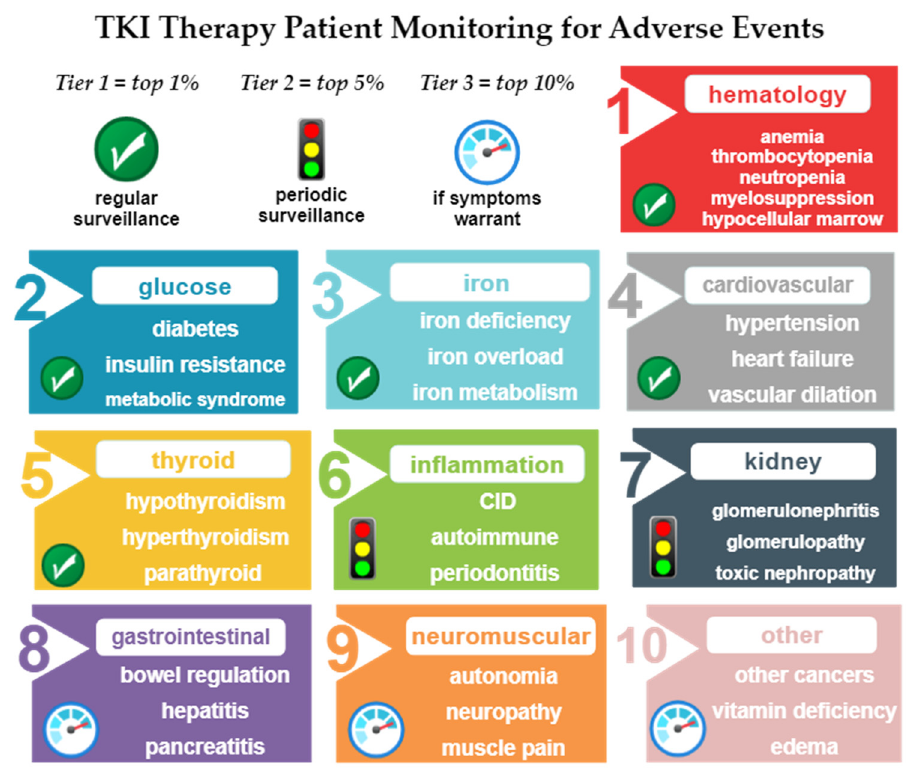
Figure 7. Summary of conditions predicted to be most relevant to tyrosine kinase. Ranked predictions are based on cross-domain literature-based discovery with link prediction and hub node network analysis. Rankings are based on normalized and aggregated HeteSim feature importance scores generated from SemNet. Tier 1 comprised approximately the top 1% of aggregated nodes: hematological conditions (1), glucose (2), iron homeostasis (3), cardiovascular disorders (4), and thyroid disorders (5). The second tier comprised approximately the top 5% of aggregated nodes: inflammation (6) and kidney disorders (7). The third tier comprised approximately the top 10% of aggregated nodes: gastrointestinal symptoms or disorders (8), neuromuscular disorders (9) and other (10). “Other” was used to denote conditions that ranked within the top 10% of aggregated and normalized related nodes but could not be described by a single cohesive functional category. The suggested surveillance categories were based on feature importance by tier: tier 1 suggests regularly scheduled surveillance, tier 2 suggests less frequent (periodic) surveillance, and tier 3 suggests surveillance only when symptoms are present.